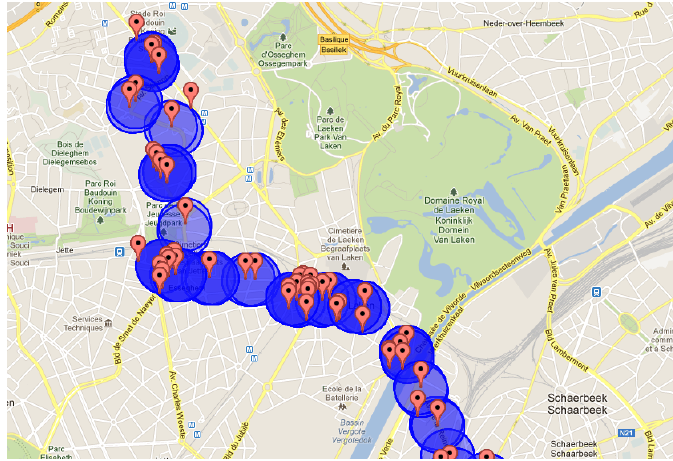
Figure 8. Places of interest less than 200 m away from a stop of Tram 94 (zoomed-in). Query